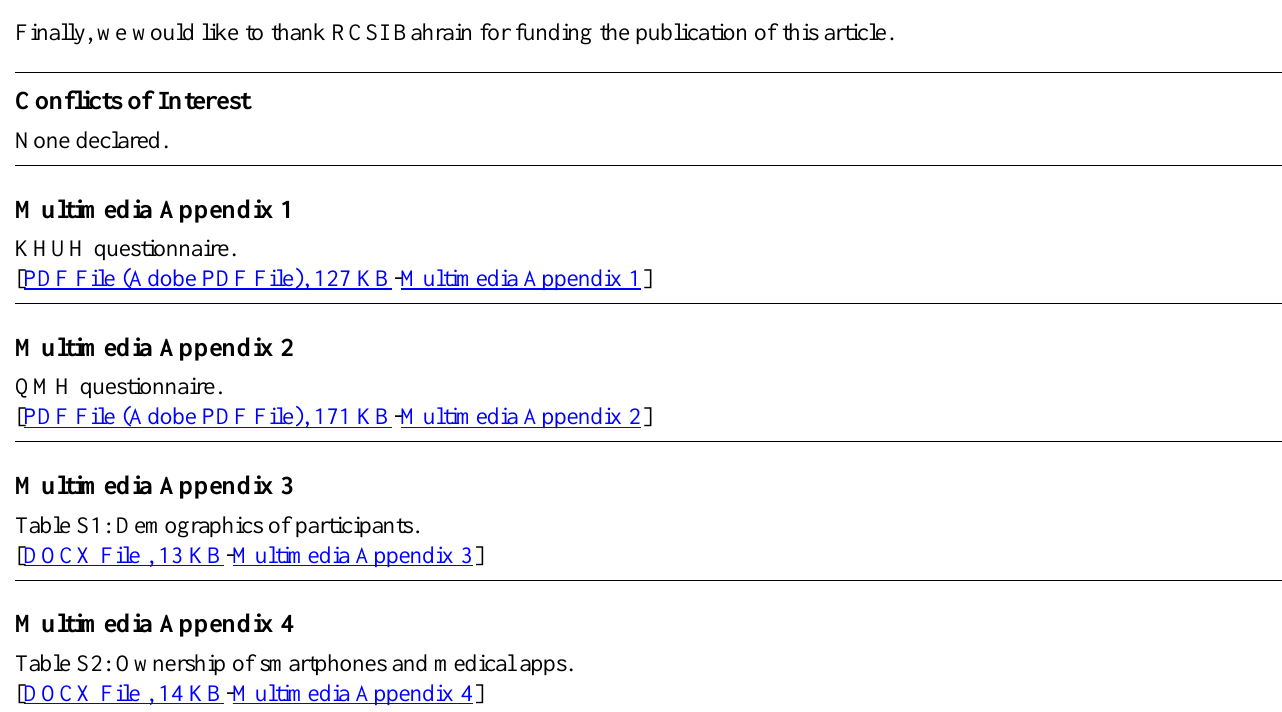
Table S2: Ownership of smartphones and medical